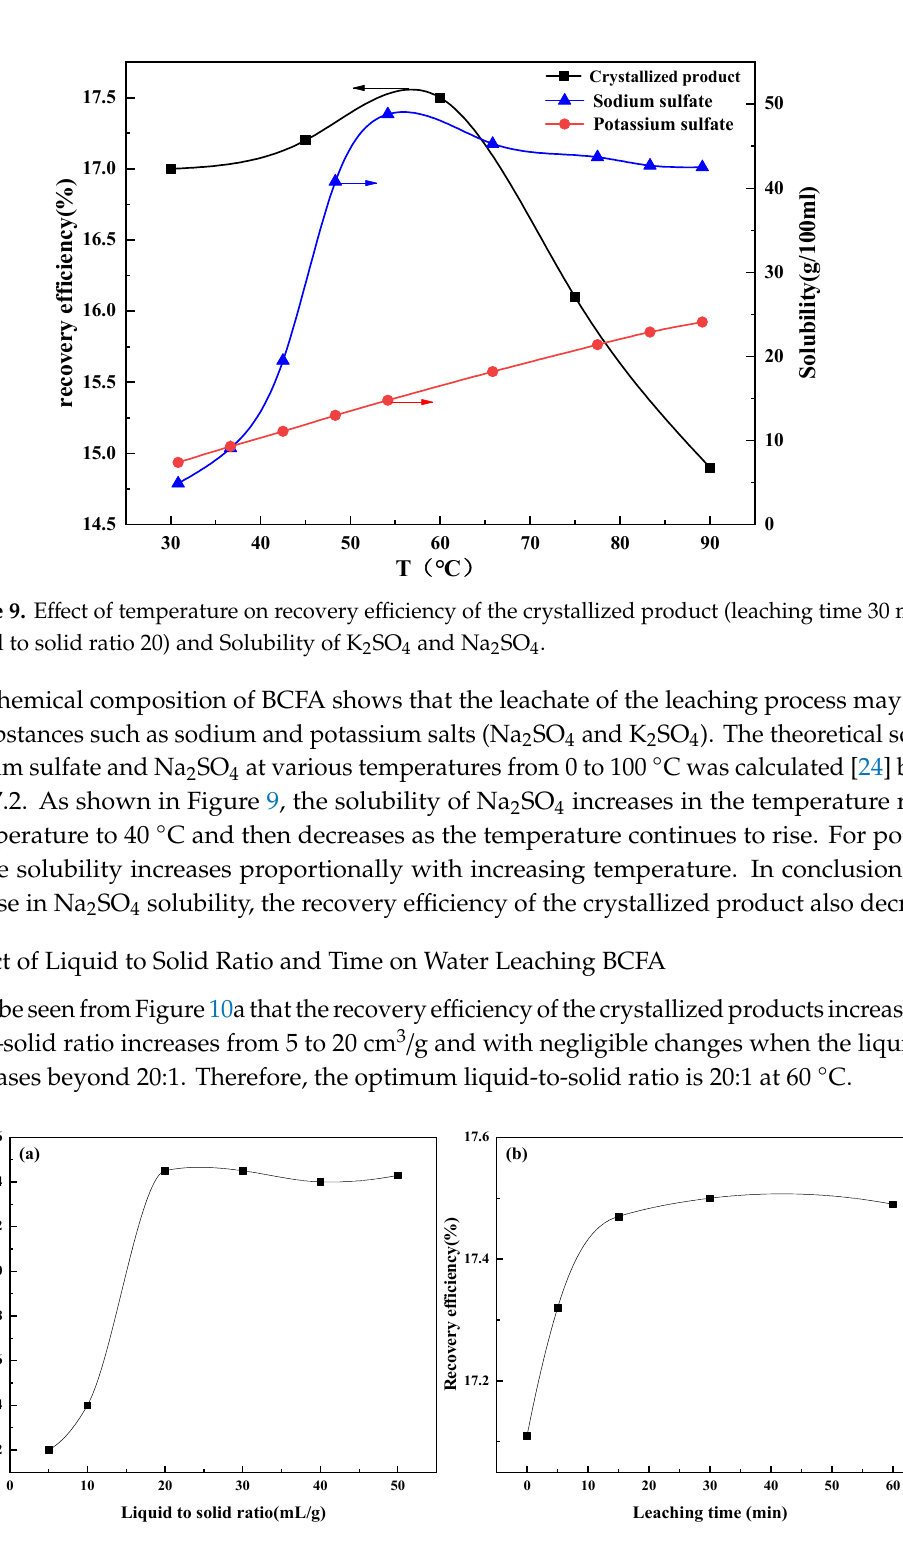
Figure 10. ( a ) Effect of liquid-to-solid ratio on recovery efficiency of the crystallized product (washing time 30 min, temperature 60 °C), ( b ) Effect of leaching time on recovery efficiency of the crystallized product (liquid-to-solid ratio 20, and temperature 60 °C).